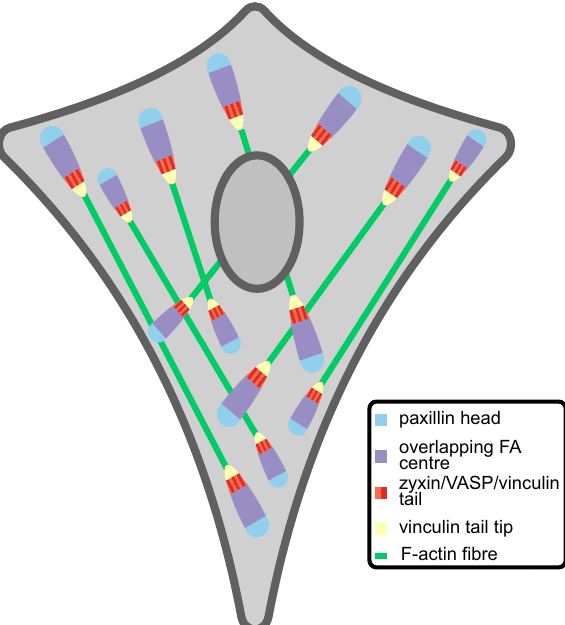
Figure 7. Schematic model summarizing the data. Schematic representation of the distribution of hallmark FA proteins paxillin, vinculin, zyxin and VASP along the long axis of FAs within cells. For clarity the model is not drawn to